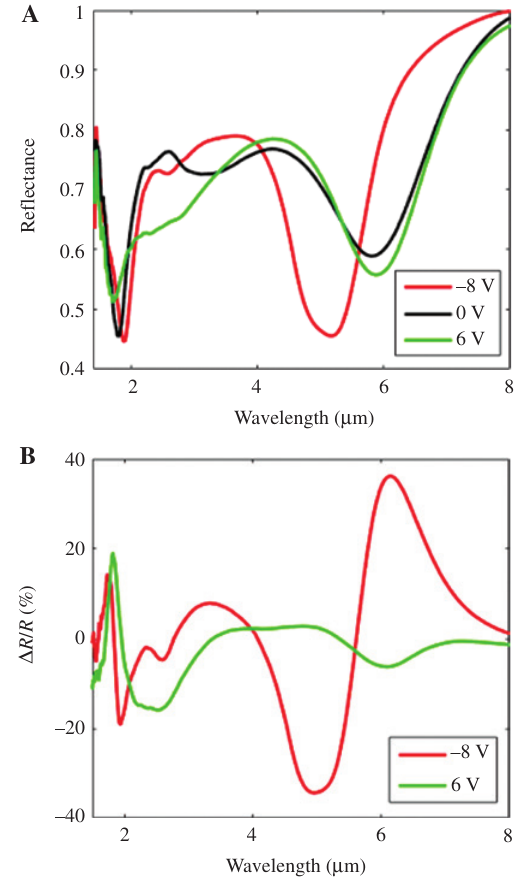
Figure 10: The experimental demonstration of active tuning for device D3 (P = 1.0 μ m, W = 850